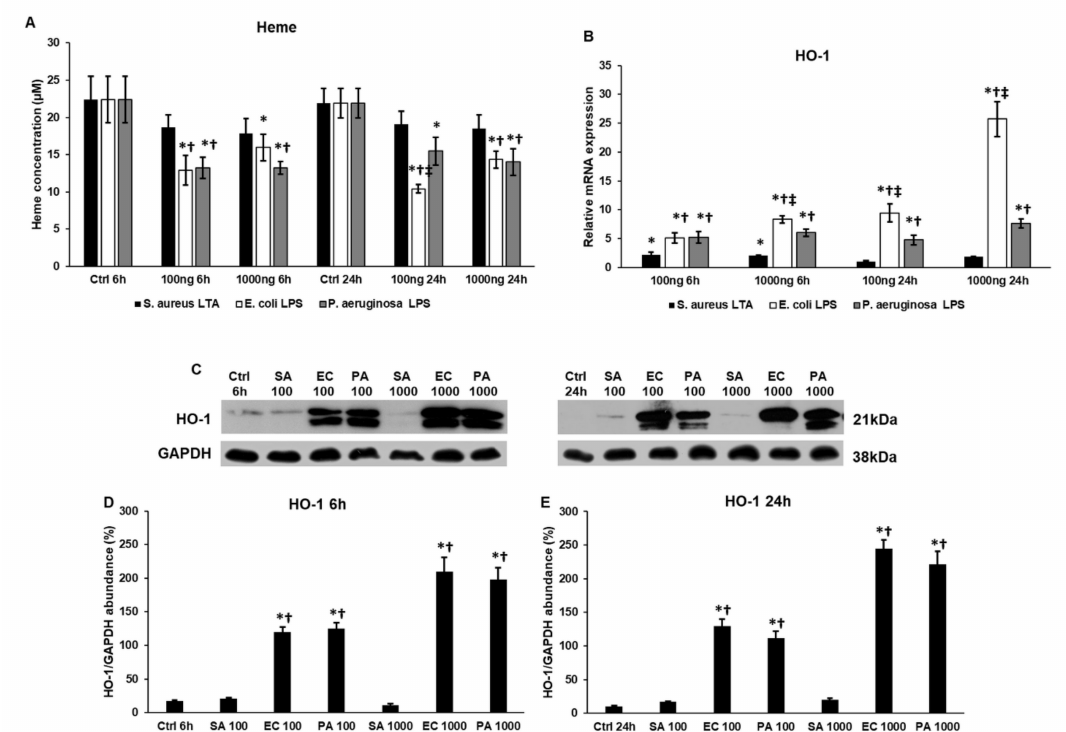
Figure 7. Heme concentration measurements, mRNA and Western blot analyses of heme oxygenase-1 in lipoteichoic acid (LTA)- and lipopolysaccharide (LPS)-treated THP-1 cells. Heme concentration of the treated THP-1 cells was determined using a Heme Assay Kit. Real-time PCR was performed with SYBR Green protocol. β -actin was used as internal control for the normalization. The relative expression of untreated controls was regarded as 1. For the Western blots, the same amount of protein from cell lysates was separated by SDS-PAGE using 12% polyacrylamide gel, transferred by electroblotting to nitrocellulose membranes. The membranes were probed with anti-HO-1 polyclonal rabbit antibody according to the manufacturer’s protocol. GAPDH was used as loading control. ( A ) Heme concentrations of LTA- and LPS-treated THP-1 cells. ( B ) mRNA levels of HO-1 in treated THP-1 cells. ( C ) Western blot analysis of HO-1 protein in THP-1 cells treated with S. aureus LTA, E. coli LPS and P. aeruginosa LPS. ( D , E ) Optical density analyses of HO-1 in THP-1 cells. The columns represent mean values and error bars represent standard deviation (SD) of three independent determinations ( n = 3). Heme measurements and real-time PCR determinations were carried out in triplicate in each independent experiment. An asterisk * marks p < 0.05 compared to the controls. A cross † indicates p < 0.05 compared to LTA treatment and a double cross ‡ shows p < 0.05 compared to P. aeruginosa LPS treatment. Abbreviations: SA: S. aureus LTA; PA: P. aeruginosa LPS; EC: E. coli